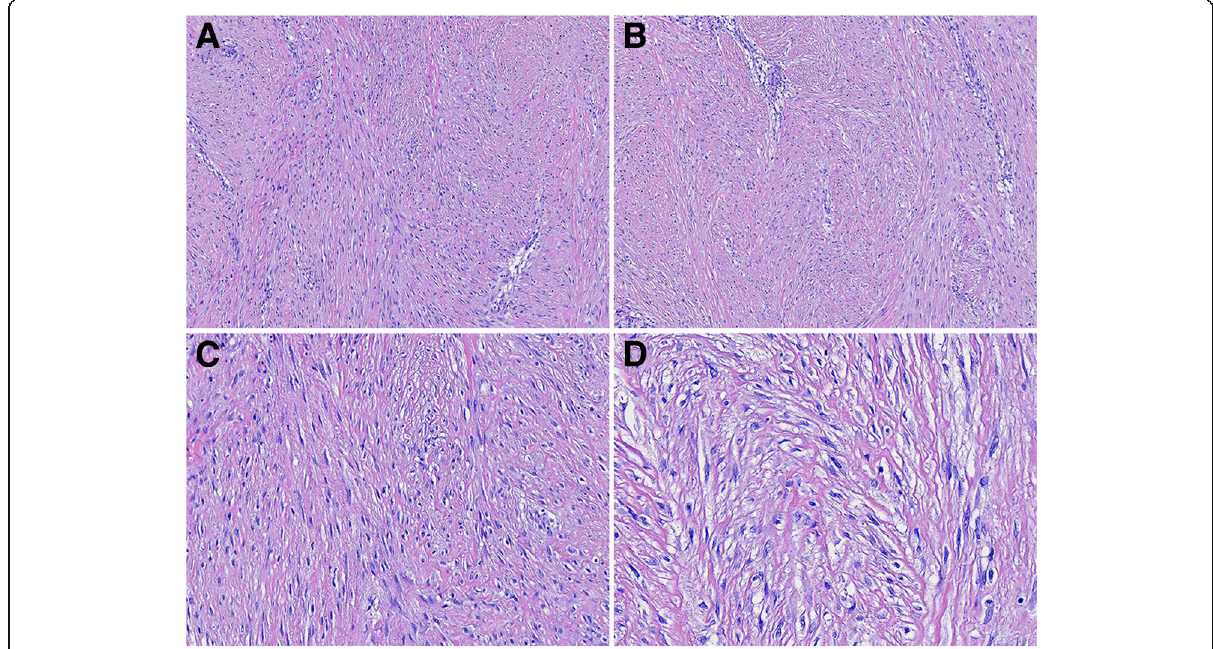
Fig. 1 Histology of DTF samples. Tumors were poorly circumscribed, with evidence of local soft tissue infiltration. The samples were consisted of proliferating spindle-shaped fibroblasts, myofibroblasts and collagen ( a , 100×). Fibroblasts were sparse or vacuolar ( b , 100×). Cells lacked nuclear hyperchromasia and were arranged in long sweeping bundles ( c , 200× and d , 400×)